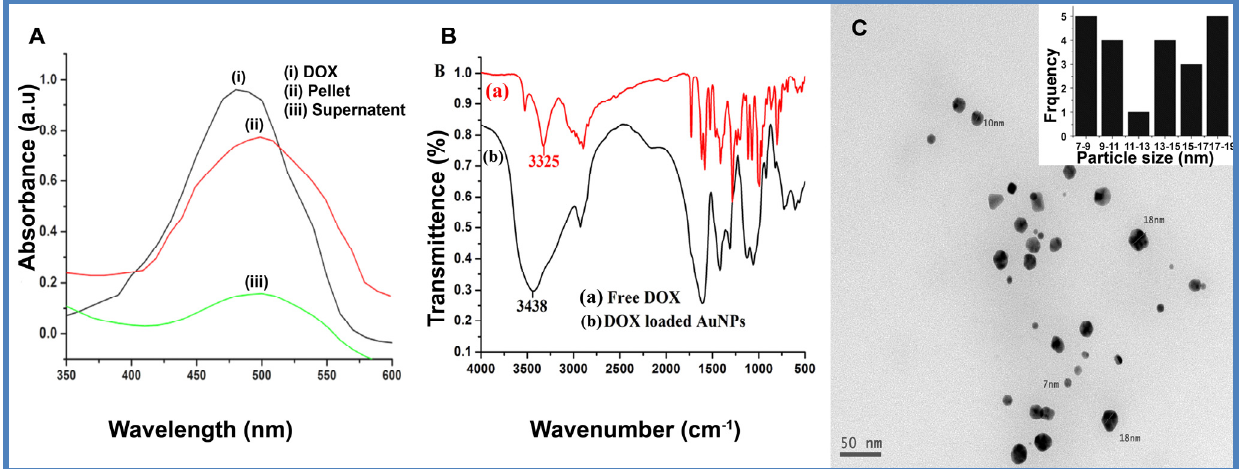
Figure 3. Spectral analysis of DOX loaded AuNPs. ( A ) UV-visible spectra of native DOX solution, DOX bound to AuNPs and unbound DOX; ( B ) FTIR spectra of (a) native DOX and (b) DOX loaded AuNPs; and ( C ) TEM image of DOX loaded AuNPs and inset image showing particle size distribution